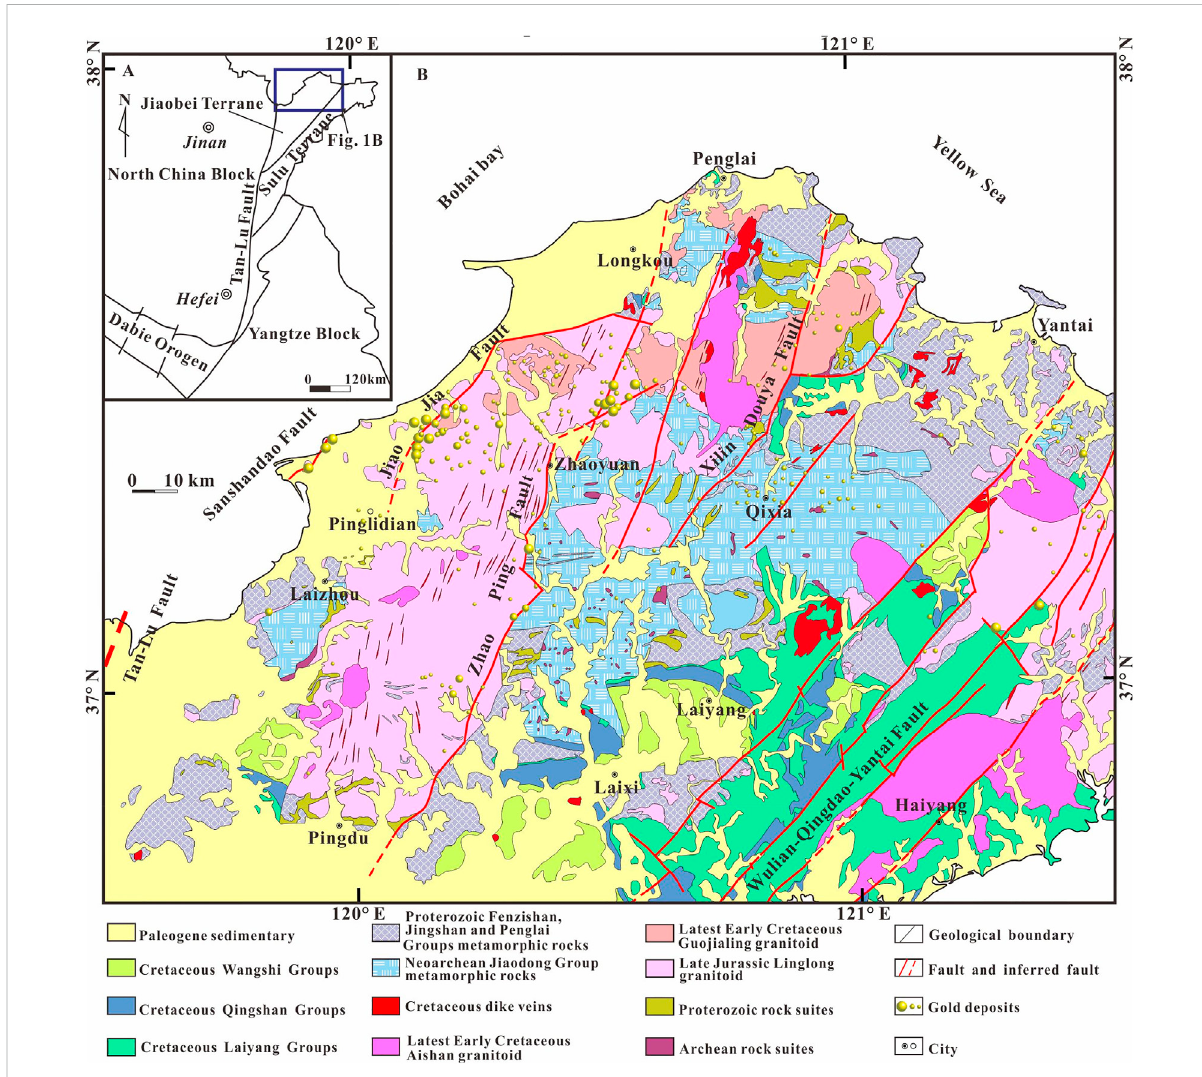
FIGURE 1 Sketch map of the Jiaodong Peninsula (A) and a regional geological map of the Jiaodong gold province showing the gold deposit locations (B) (modi fi ed from Yang et al., 2019; Li et al., 2020; Song et al.,